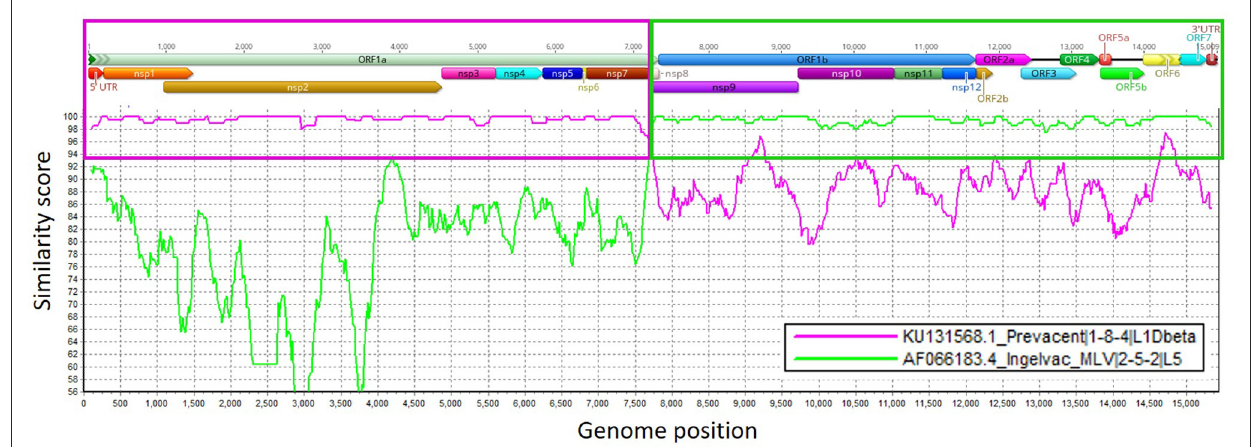
FIGURE1 Similarity plot analysis using the isolate USA/IN105404/2021 strain as the query sequence against Ingelvac ® PRRS MLV and Prevacent ® PRRS. Genome regions (ORFs) and non-structural protein (NSP) genome regions of the recombinant strain are presented at the top of the plot. Purple and green boxes outline the recombination breakpoints, similarity scores, and genome regions that were derived from Prevacent ® PRRS (major) and Ingelvac ® PRRS MLV (minor) parental strains. The closer the similarity score is to 100 (y-axis), the more similar the compared strains are. Genome regions were plotted in Geneious, and recombination events were determined using RDP4 and confirmed in SimPlot (1).